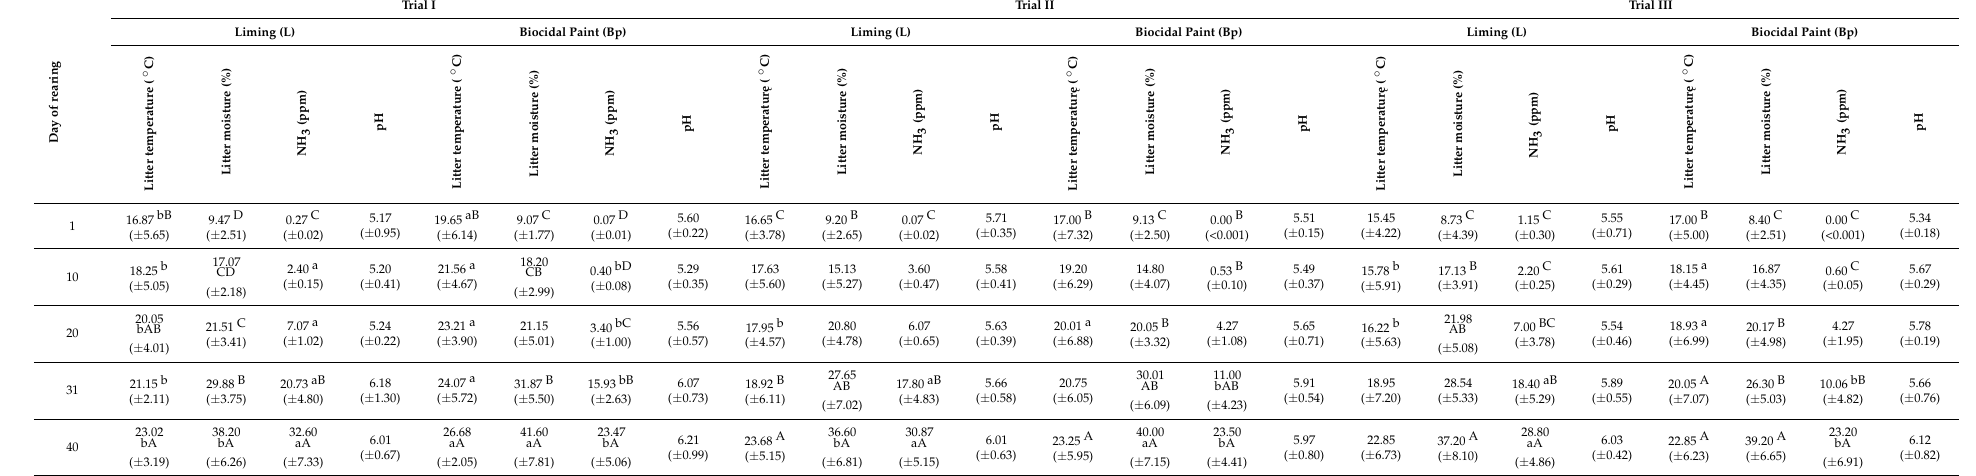
Table 10. Litter parameters during the